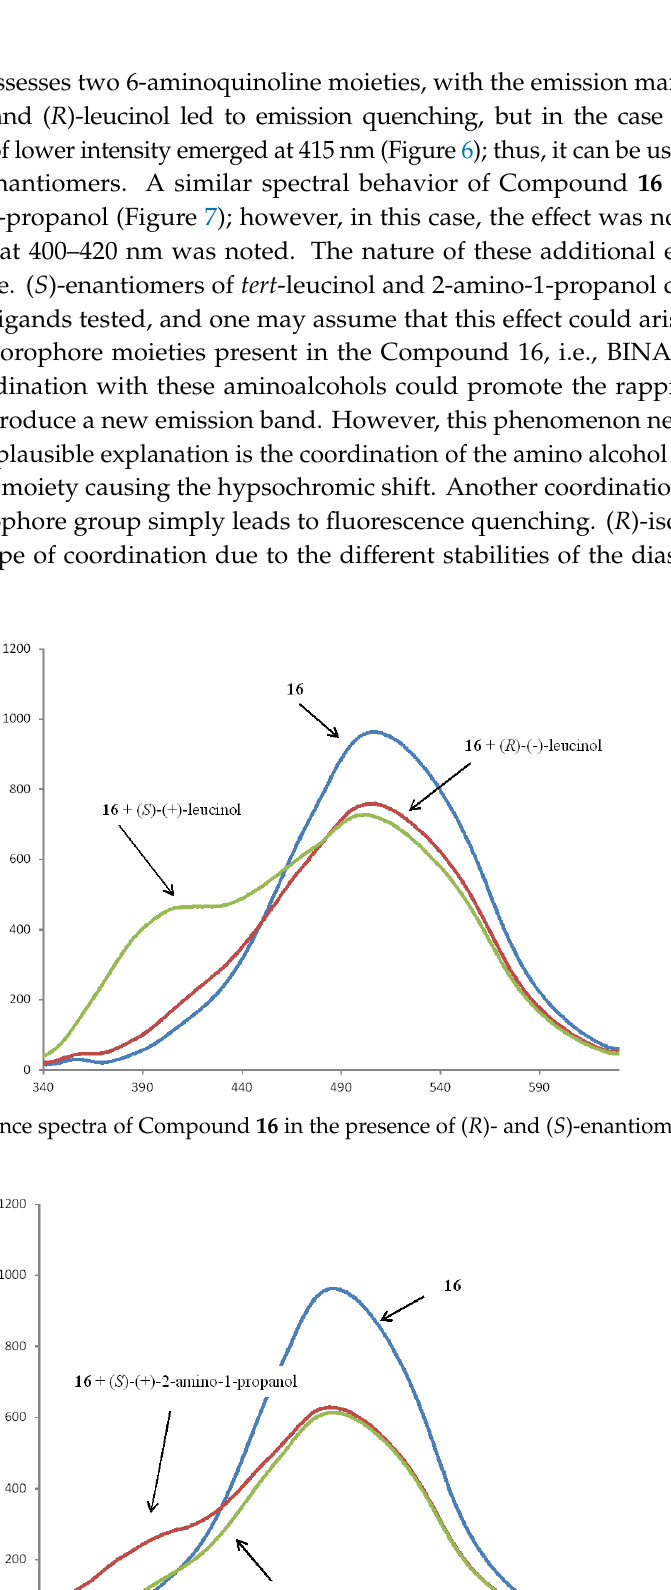
Figure 7. Fluorescence spectra of Compound 16 in the presence of ( R )- and ( S )-enantiomers of 2-amino-1-propanol (1000 equiv.).